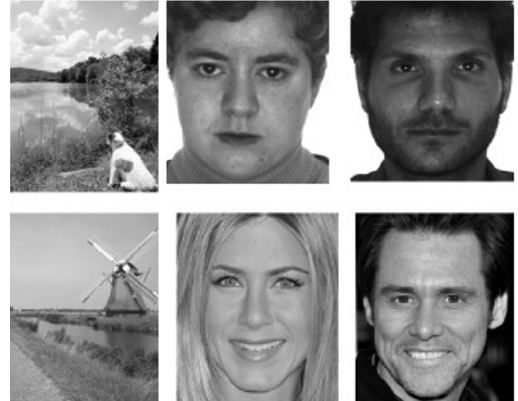
Figure 2. Some examples of images shown to participants during the data acquisition process in the GANT [36]. The first column shows images of two landscapes. The last two columns, on the other hand, show images of women and men: in the first row there are images of unknown people while in the second row there are images of two famous actors.